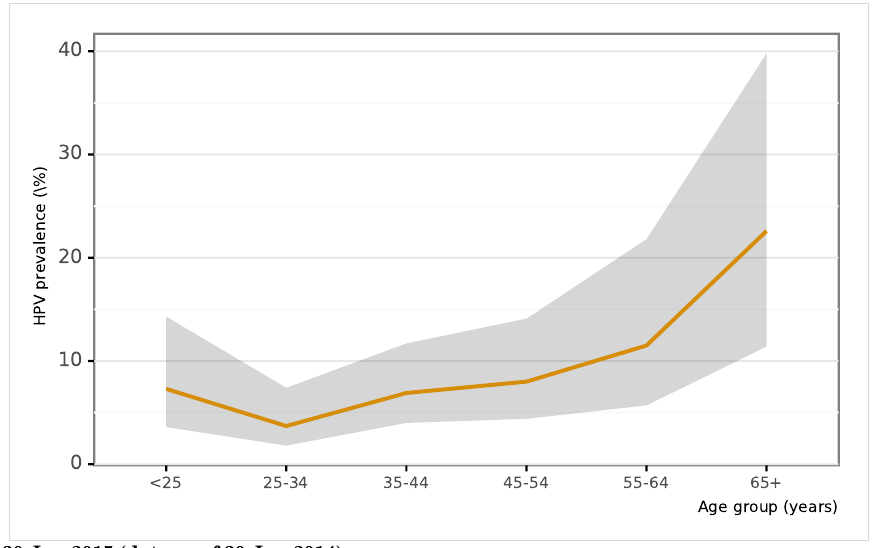
Figure 54: Crude age-specific HPV prevalence (%) and 95% confidence interval in women with normal